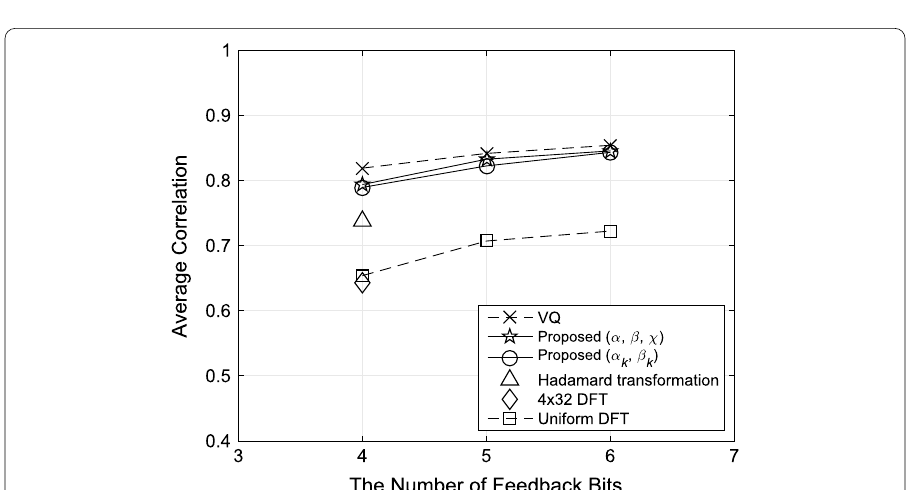
Fig. 12 Cell-average performance of codebooks for the cross-polarized antenna